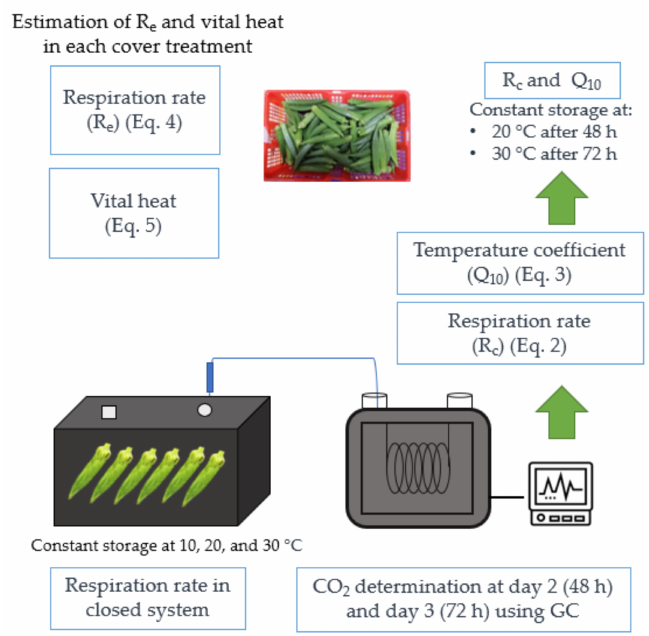
Figure 3. Determination of respiration rate and vital